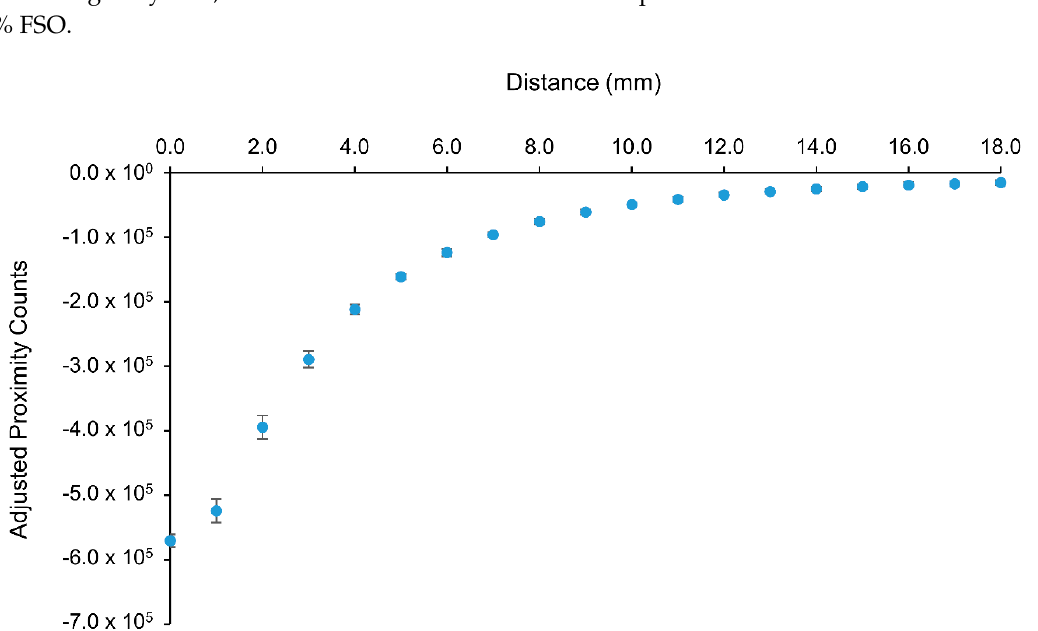
Figure A1. Sensor sensitivity was measured for multiple sensors to assess repeatability. Average sensitivity for the same three sensors after the sensor proximity counts were normalized to set the baseline counts to zero. Curves were shifted along the y-axis when the baseline offset was removed, which minimized repeatability error.